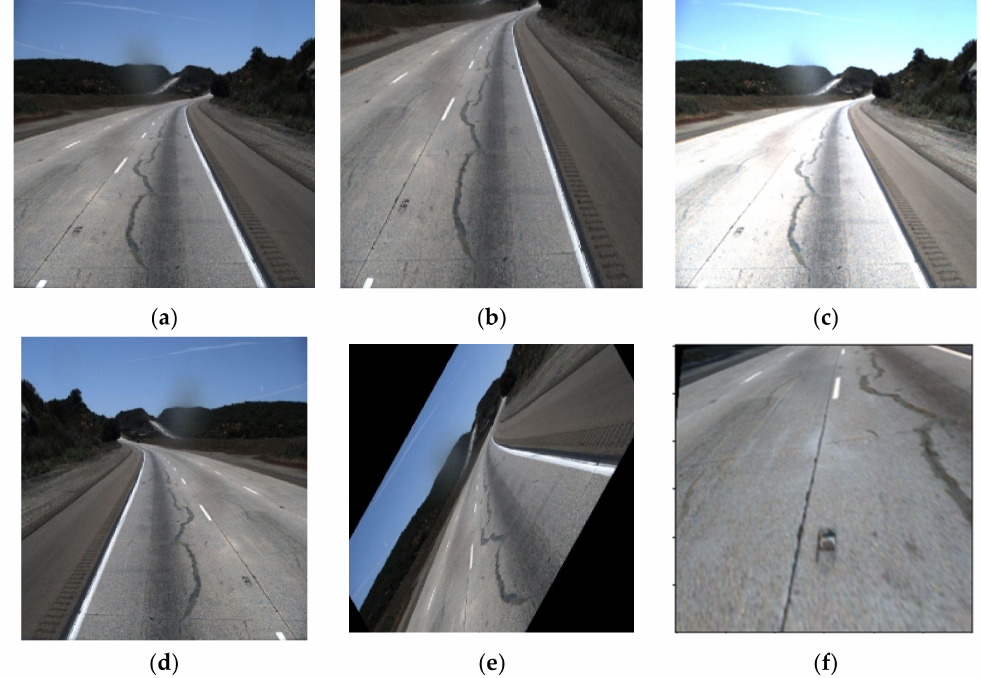
Figure 1. Different pre-processing technique ( a ) original, ( b ) cropped, ( c ) brighten ( d ) mirrored, ( e ) rotating and ( f )